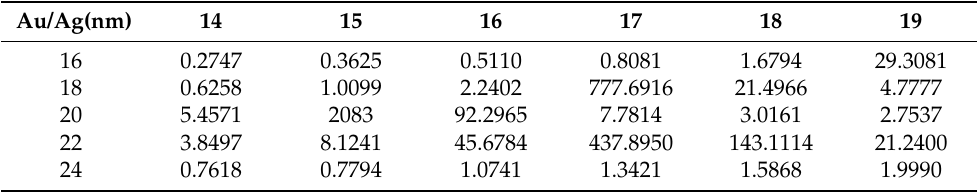
Table 1. Optimum sensitivity ( λ /RIU ) for different gold and silver thicknesses.